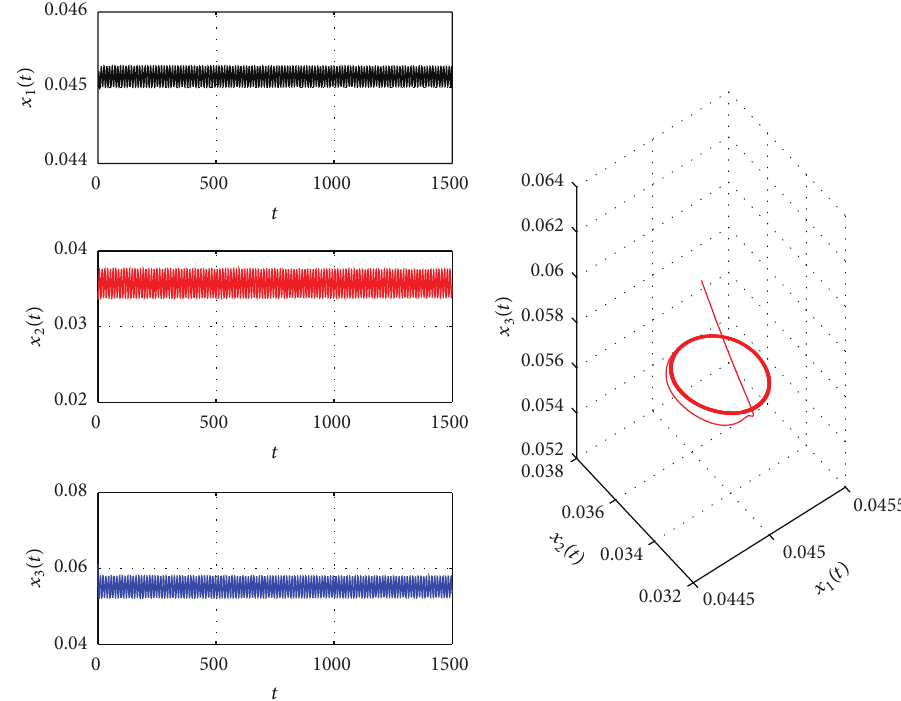
Figure 4: The trajectories and the phase graph with 𝜏 1 = 1.2, 𝜏 2 = 2.9 ; a periodic orbit bifurcate from 𝐸 ∗